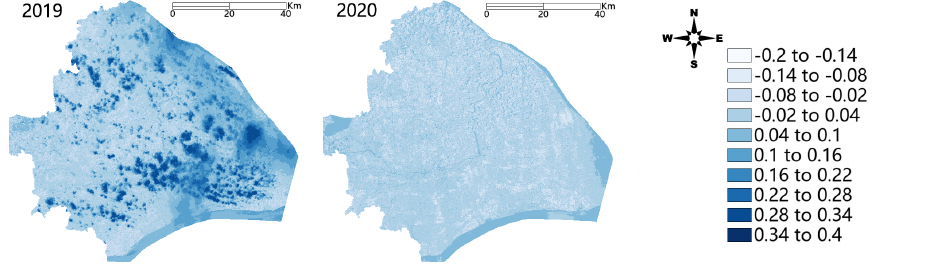
Figure 8. Wetness.